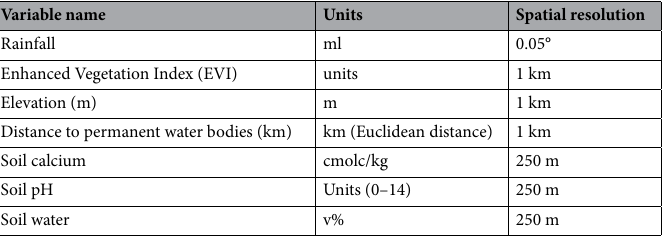
Table 1. Summary of the environmental variables used in the spatial model including variable name, unit, and spatial